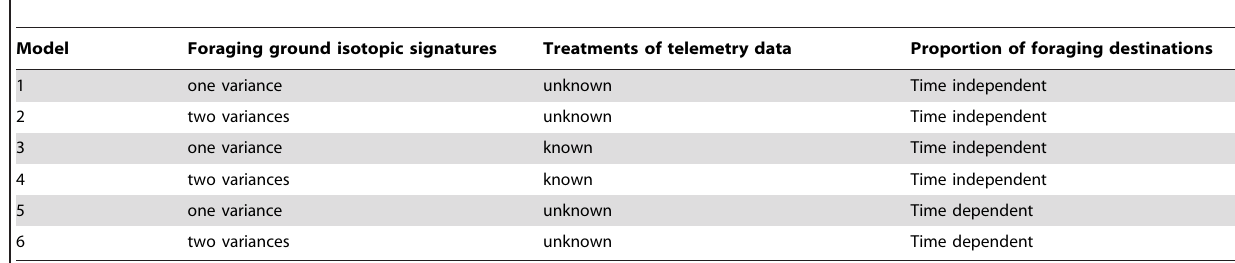
Table 3. Definitions of four models used to estimate the underlying isotopic signatures of the Eastern and Western Pacific Ocean and to assign each individual to one of the two foraging